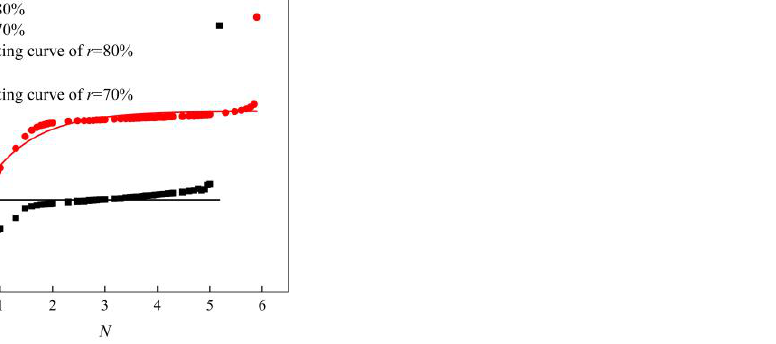
Figure 12. Exponential fitting results. (Specimens made by the powder metallurgy method, N = lg n ).